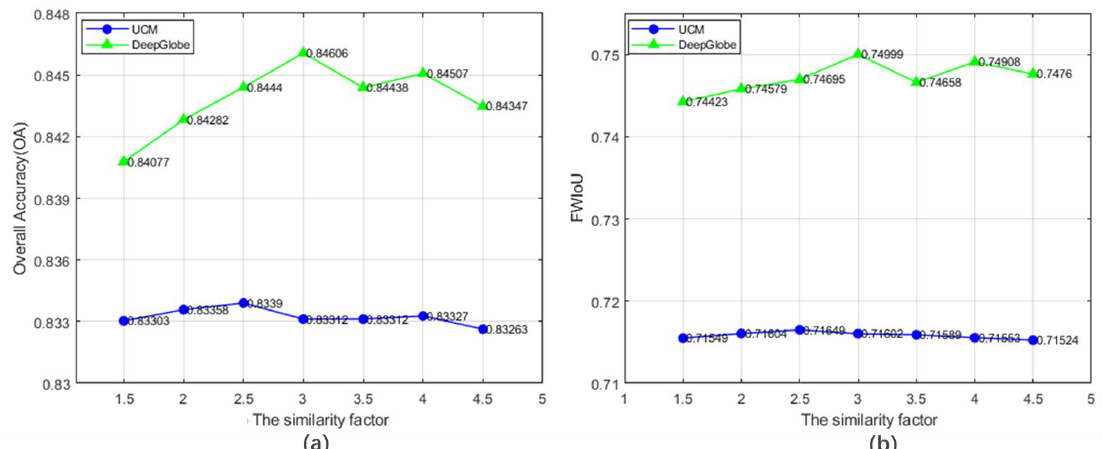
Figure 8. Sensitivity analysis of the similarity factor 𝜎 𝑤2 tested on the validation dataset. ( a ) and ( b ) present the change trend of OA and FWIoU with 𝜎 𝑤2 , respectively.